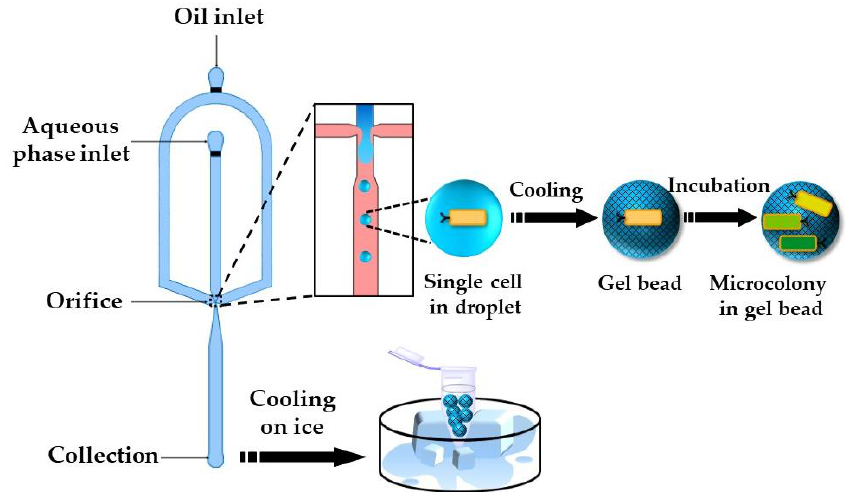
Figure 26. Encapsulation of single E. coli cells within agarose beads by temperature-controlled emulsification of an agarose solution in a flow-focusing device followed by cooling. The entrapped cells grow into monoclonal microcolonies inside the beads and can be sorted by fluorescence activated cell sorting (FACS) [105].